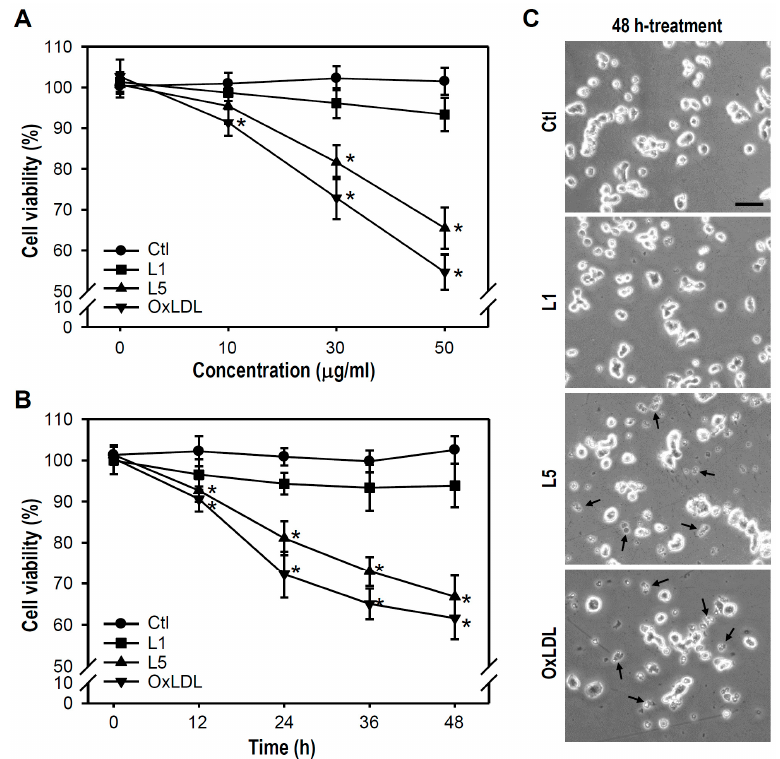
Figure 1. LDL fraction L5 shows a concentration- and time-dependent cytotoxicity to cultured PC12 cells. ( A ) Concentration-response relationships for L1 (negative control), L5, and oxLDL (positive control) were established. Indicated LDLs were applied for 24 h at various concentrations (0 to 50 µ g/mL); ( B ) Time course was determined for L1, L5, and oxLDL cytotoxicity. Cultures were treated with the indicated LDL at 30 µ g/mL for different times (0 to 48 h). In ( A , B ), the MTT reduction assay was applied to measure PC12 cell survival (viability) with untreated cells used as the control (Ctl). The number of live cells per well was calculated as a percentage of untreated control cell number. Each point is presented as the mean ± SEM from at least four independent experiments performed in triplicate. * p < 0.05 vs. Ctl at equal concentration ( A ) or at the same time point ( B ); and ( C ) Representative photos show an untreated culture and cultures treated with 30 µ g/mL of the indicated LDL for 48 h. Fragmented cell debris (putative apoptotic bodies) are indicated by arrows. Scale bar = 50 µ m.